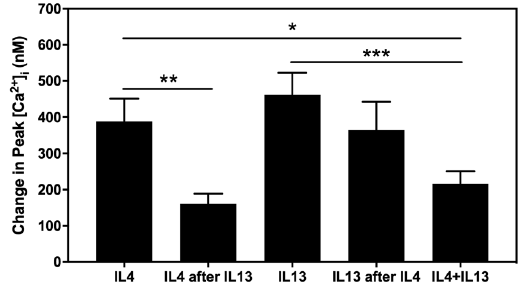
Figure 8. Effect of IL4 and IL13 on each other’s increase in intracellular [Ca 2 + ] ([Ca 2 + ] i ) in rat conjunctival goblet cells. Change in peak [Ca 2 + ] i over basal produced by 10 ng/ml IL4 or IL13 alone; or on IL4 or IL13 after a 2.5 min pretreatment with IL13 or IL4, respectively; or by a combination of both IL4 and IL13 added simultaneously. Data are mean ± SEM from eight independent experiments. * ≤ 0.05; ** ≤ 0.01; *** ≤ 0.005.